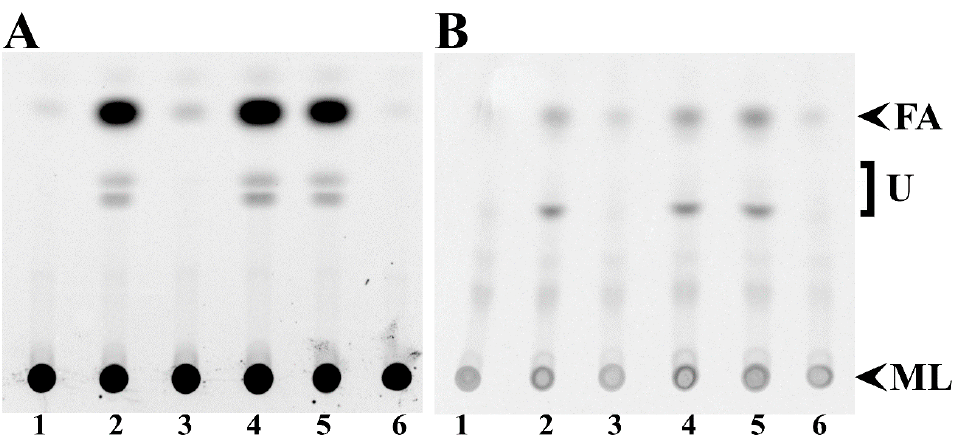
Figure 2. Expression of sma0150 or smb20650 does not abolish free fatty acid accumulation in fadD mutants of S. meliloti . Thin-Layer Chromatography (TLC) analyses of cellular lipid extracts ( A ) and lipid extracts of spent media ( B ) obtained either from wild type S. meliloti GR4 carrying the empty vector pNG28 (lane 1) or from its fadD mutant QS77 carrying either pNG28 (lane 2), pRCanul2 ( smc02162 , lane 3), pRCanul1 ( sma0150 , lane 4), pRCanul3 ( smb20650 , lane 5), or pRCanul 4 ( fadD Ecoli , lane 6) grown on Robertsen MM into the stationary phase (OD 620 = 1.2, 66 h of growth). The membrane lipids (ML) did not migrate from the origin and the spot for fatty acids (FA) is indicated. U: unidentified lipid spots. A single experiment representative of three repetitions is shown.